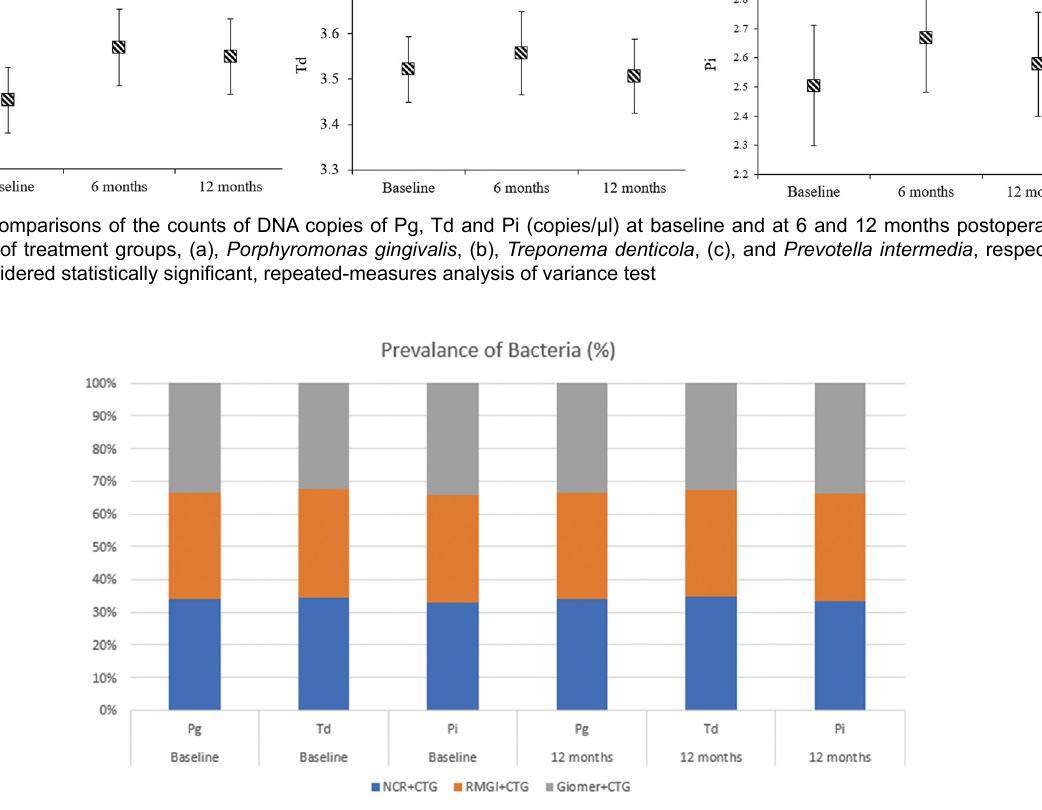
Figure 3- The frequency detection of Pg, Td and Pi at baseline and at 12 months postoperatively in the treatment groups. p<0.05 considered statistically significant, chi-square Table 2- Change in counts of DNA copies of Pg, Td and Pi (copies/µl) between treatment groups with the changes of probing depth between 12 months postoperatively and baseline